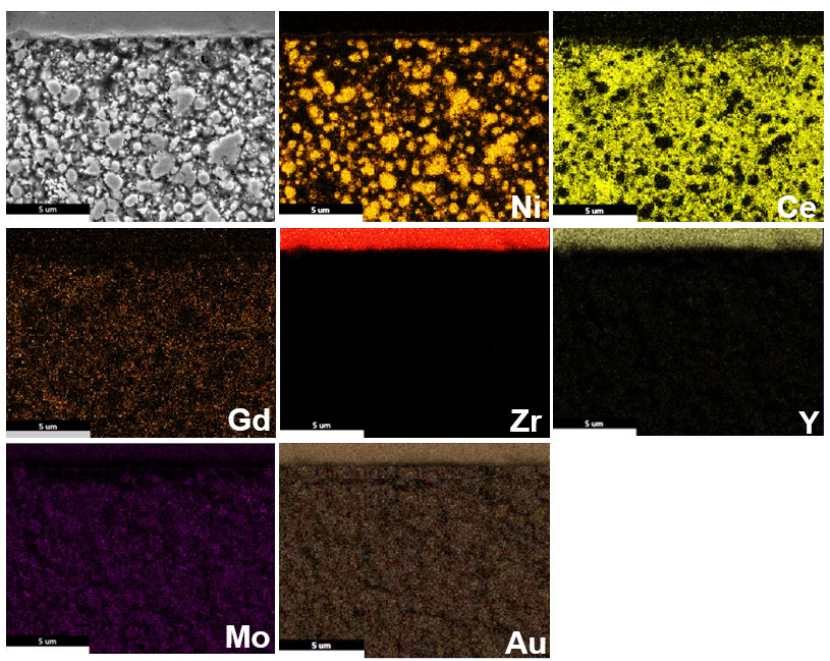
Figure 7. Elemental mapping on the fuel electrode side, at the cross-section of the 3Mo-3Au-Ni- GDC/8YSZ/GDC/LSCF single cell after 1700 h steam electrolysis operation at 900 °C with 63 vol.% H 2 O + 30 vol.% N 2 + 7 vol.% H 2 feed gas mixture and − 0.3 A ‧ cm − 2 current load.